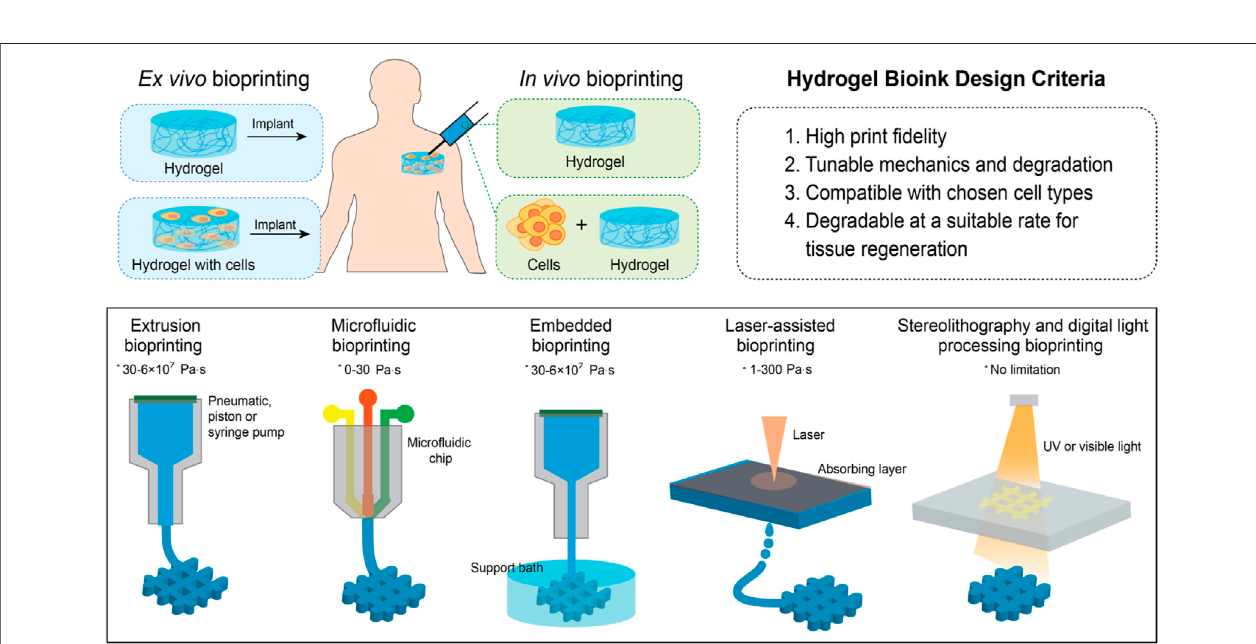
Frontiers in Bioengineering and Biotechnology |